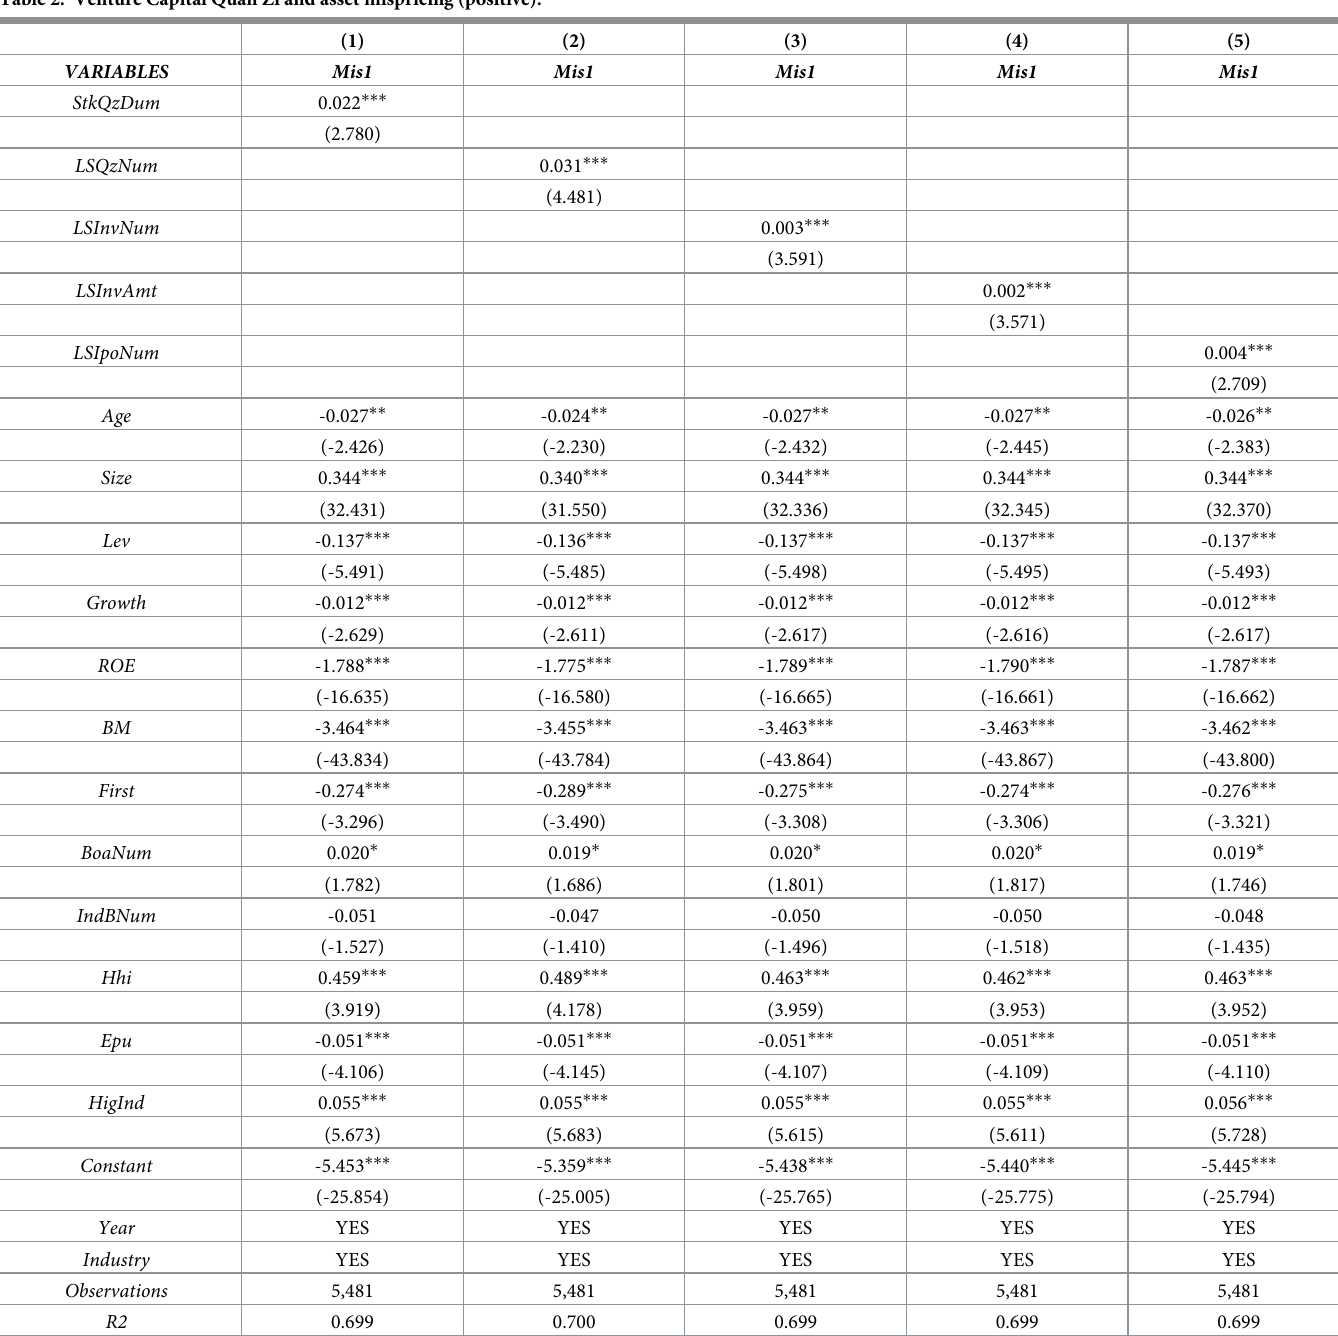
Table 2. Venture Capital Quan Zi and asset mispricing